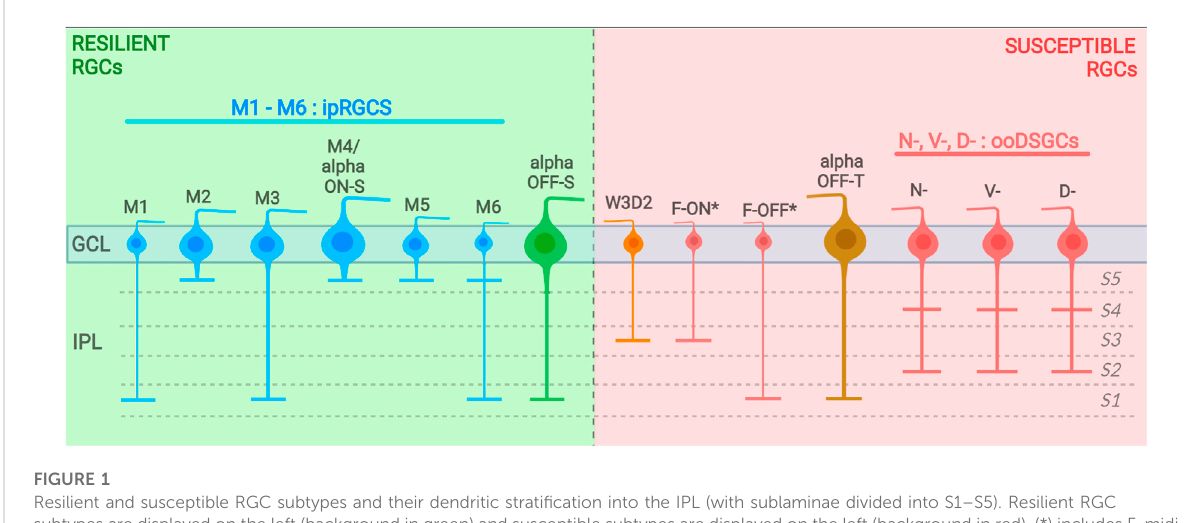
FIGURE 1 Resilient and susceptible RGC subtypes and their dendritic strati fi cation into the IPL (with sublaminae divided into S1 – S5). Resilient RGC subtypes are displayed on the left (background in green) and susceptible subtypes are displayed on the left (background in red). (*) includes F-midi and F-mini types. GCL, ganglion cell layer; IPL, inner plexiform layer.